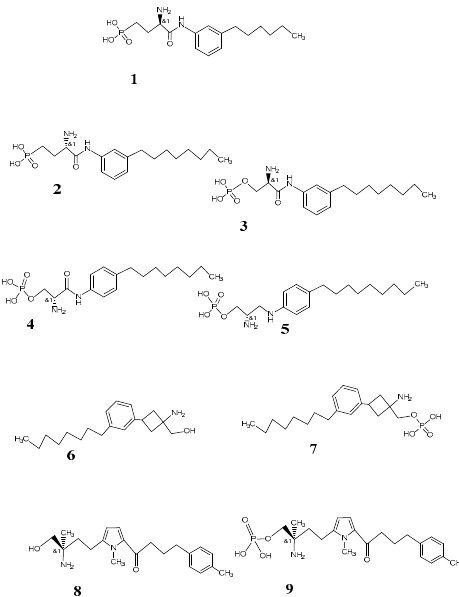
Figure 2. S1P1 ligands 1 : W146 (ML056); 2 VPC4416; 3 VPC 23019; 4 VPC 22173; 5 VPC22277; 6 VPC 3090; 7 VPC 3090P; 8 CS-0777; 9 CS-0777P. (For IUPAC names of all compounds according to